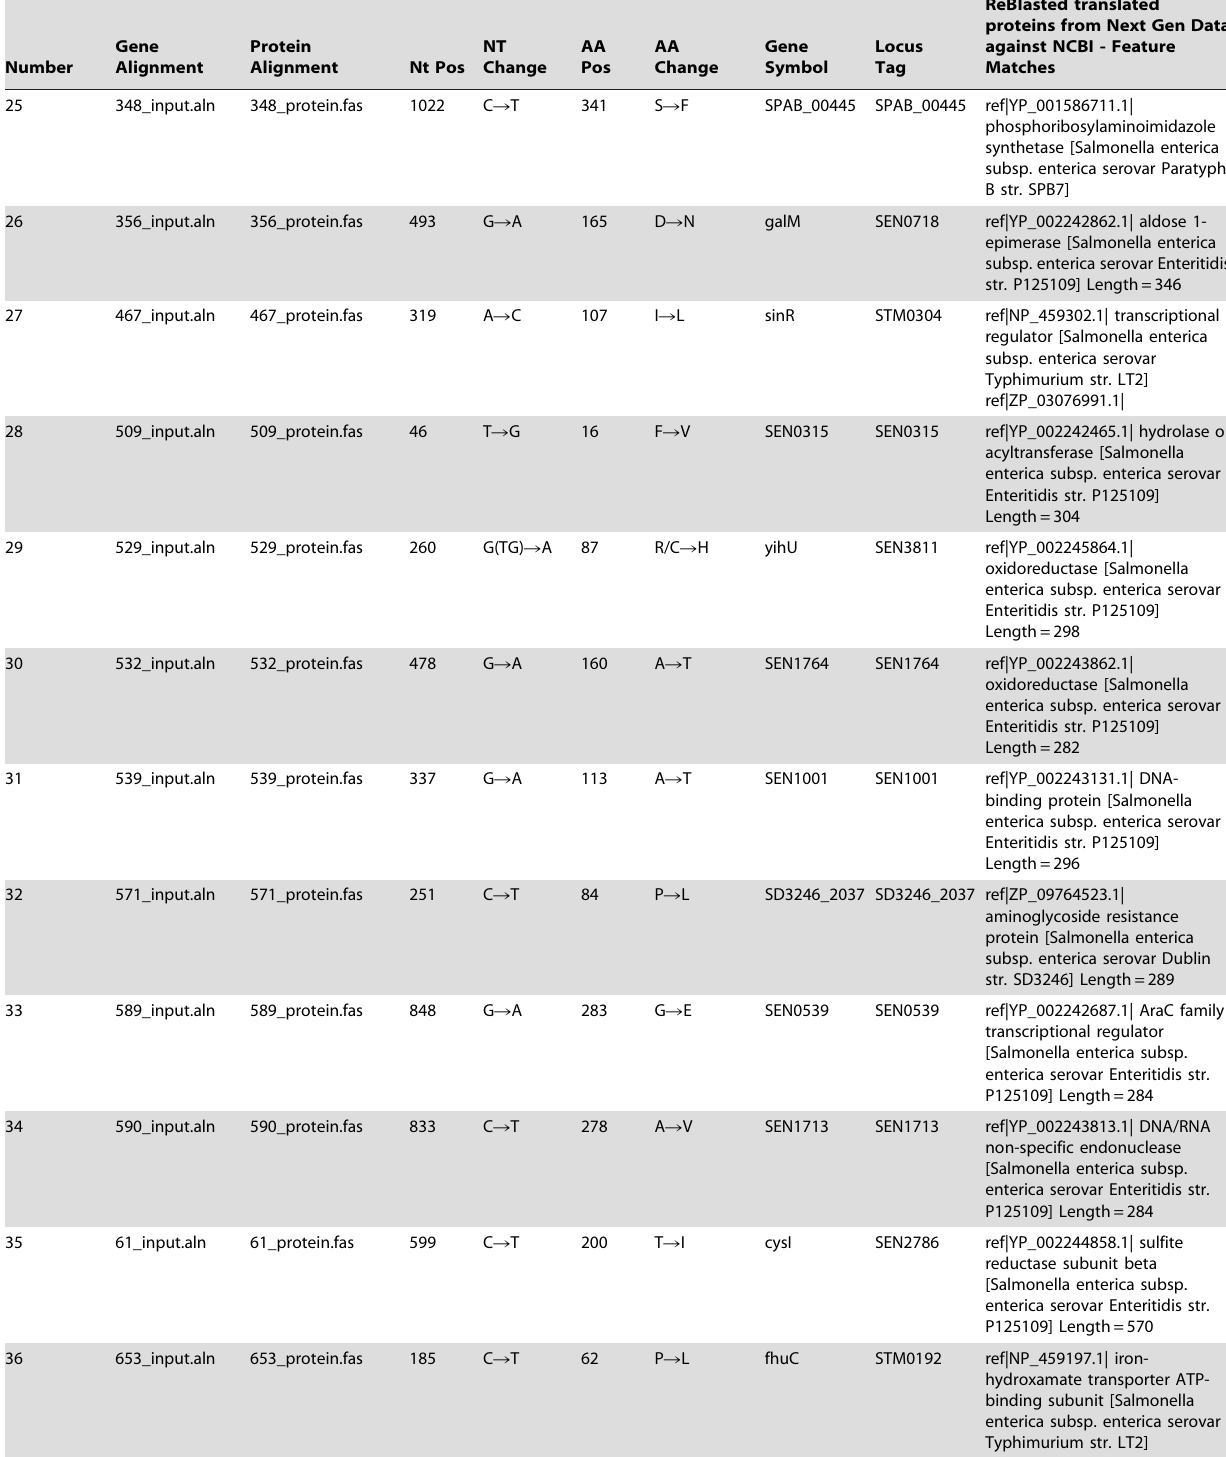
Variable genes observed that may define Salmonella